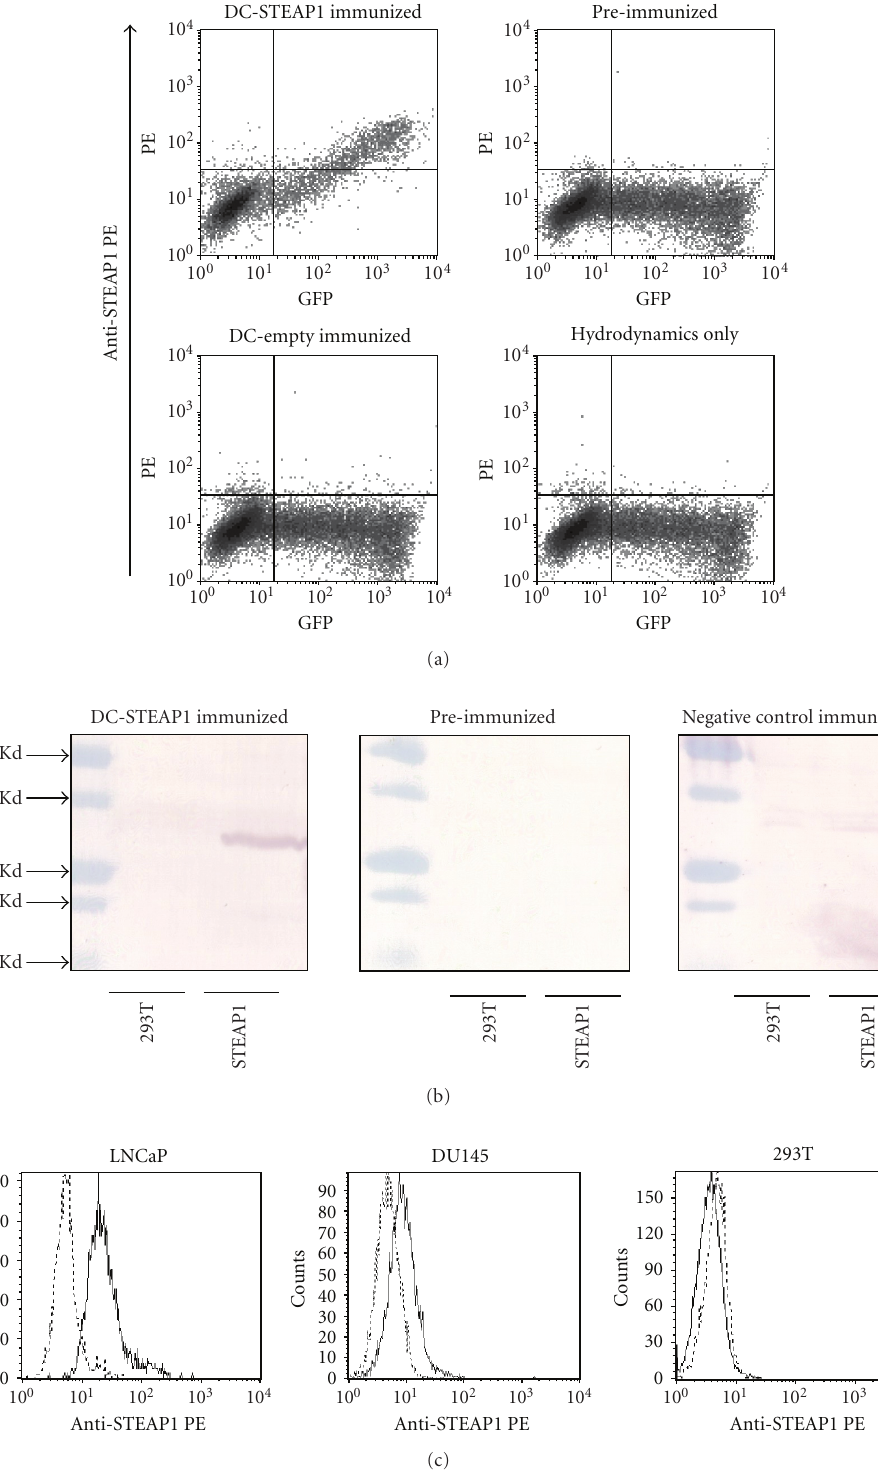
Figure 1: hSTEAP1 immunization. (a) Flow cytometry analysis to detect anti-hSTEAP1 in sera from immunized mice. Upper panels, DC-STEAP1 immunized (left), preimmunized (right). Lower panels, DC-empty immunized, with booster immunization (left), booster immunization only without DC immunization (right). 293T cells transiently transfected with pMRX-hSTEAP1-IRES-GFP were stained with sera, followed by PE conjugated antimouse IgG. (b) Western blotting analysis of hSTEAP1 immunization. The lysates of 293T cells and 293T cells transfected with pCAGGS-hSTEAP1 were probed with serum from immunized mice. (c) Anti-hSTEAP1 flow cytometry analysis in human prostate cancer cells. From left to right: LNCaP, DU145, and 293T cells. Solid line: anti-STEAP1 serum. Dashed line: preimmune